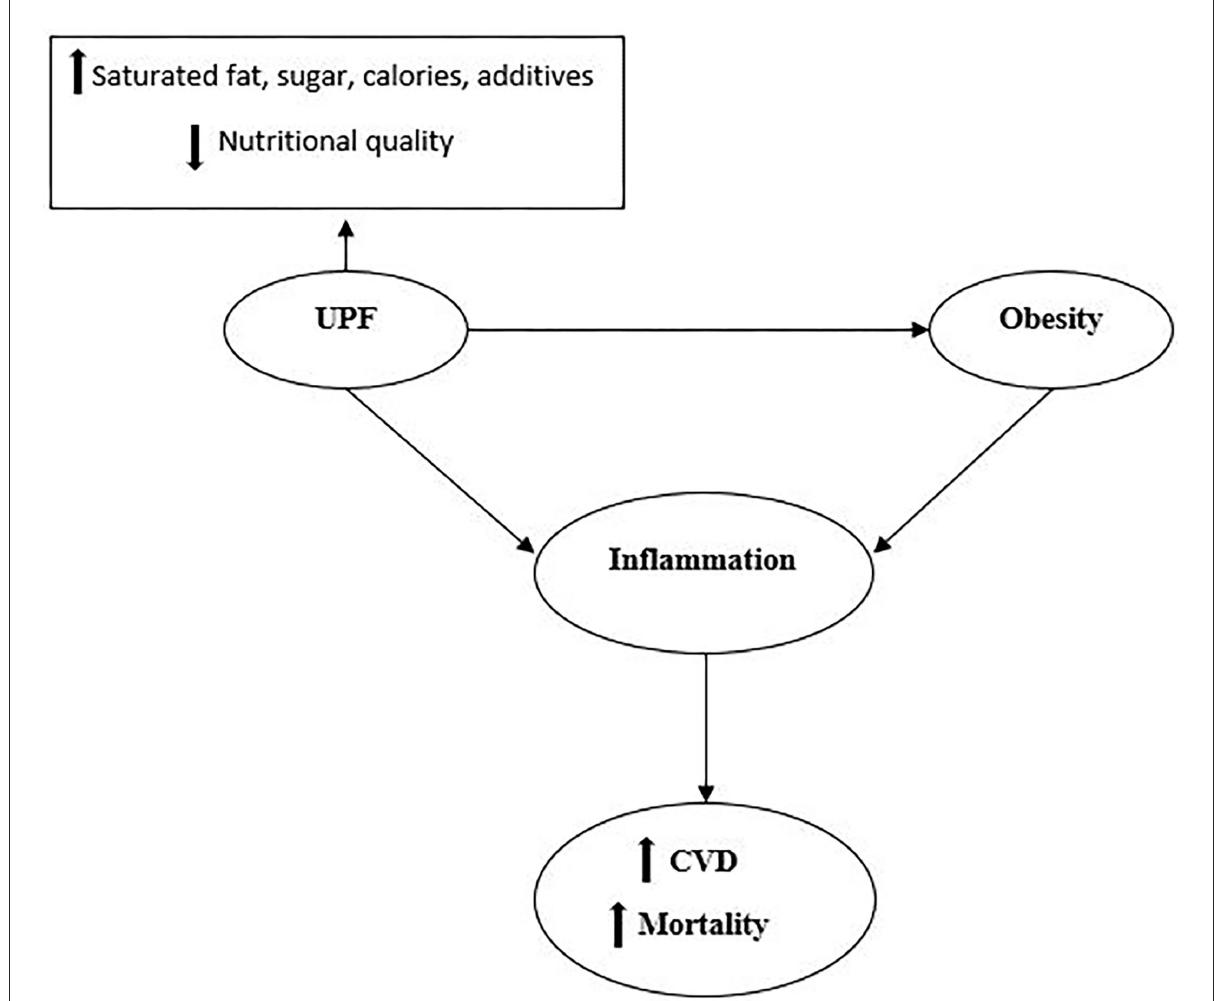
FIGURE1 UPFs have higher levels of saturated fats, sugar, salt, additives, calories, and lower nutritional quality. Consumption of UPFs is suggested to have associations with obesity. Both obesity and consumption of UPFs could stimulate the whole chronic inflammation cascade and enhance the risk of CVD and all-cause